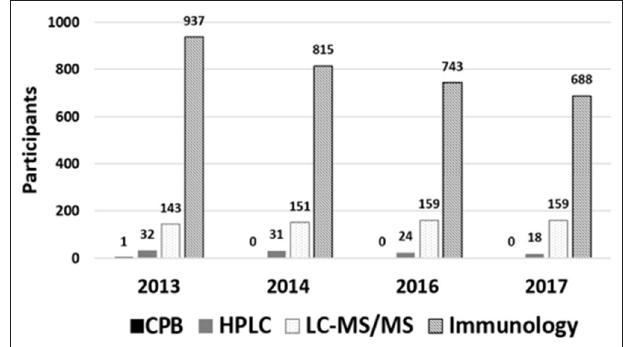
FIGURE 2 | Methods used in the largest proficiency testing scheme for vitamin D analysis (25,